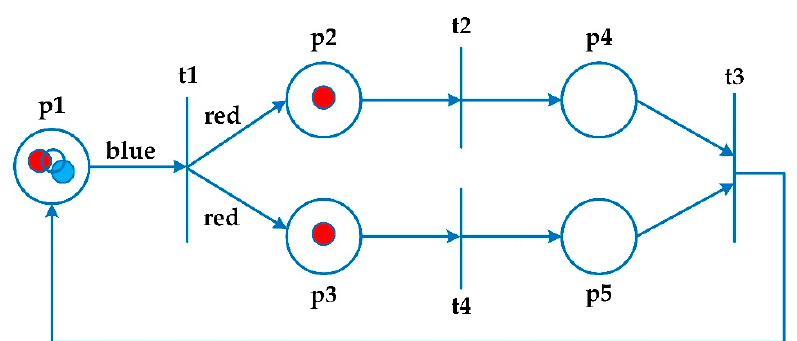
Figure 3. A sample coloured Petri net diagram, amended from [27] .